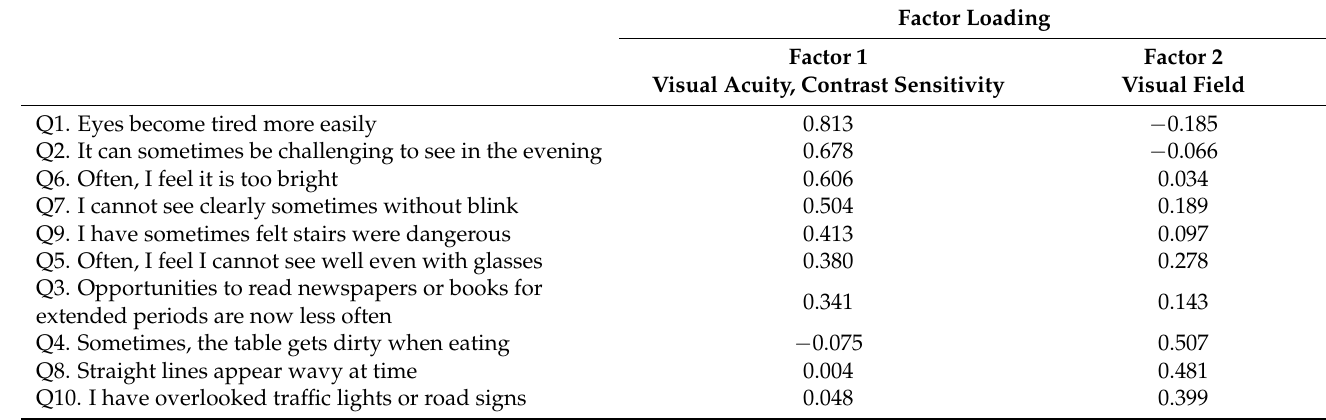
Table 2. Exploratory factor analysis in eye frailty